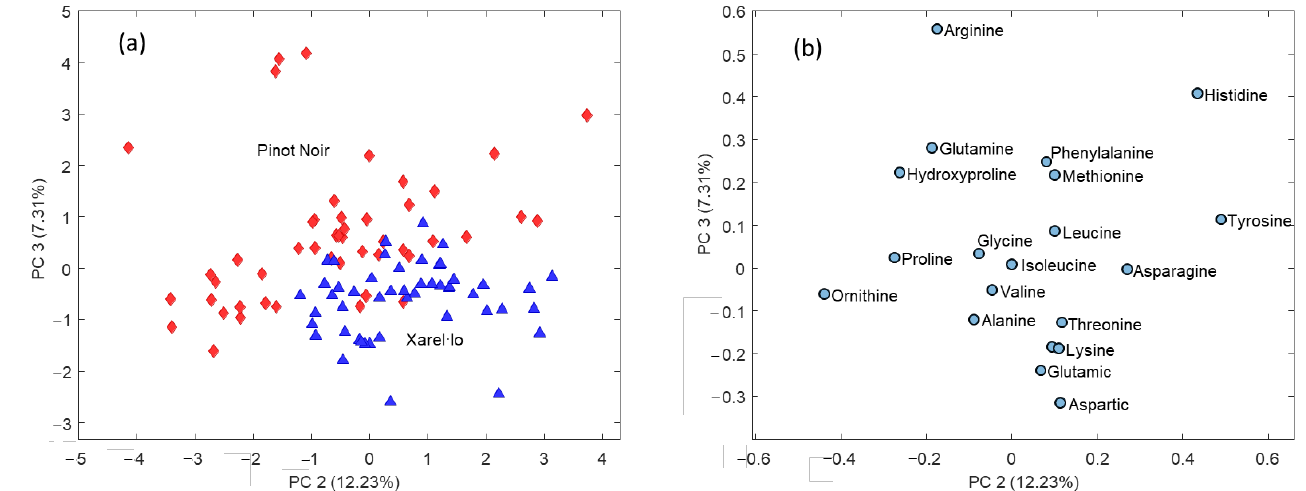
Figure 3. PCA results for the exploratory evaluation of fermented samples as a function of variety using AA profiles as the data. ( a ) Plot of scores of PC2 vs. PC3. ( b ) Plot of loading of PC2 vs. PC3. Sample assignment: triangle, xarel·lo; rhombus, pinot noir.